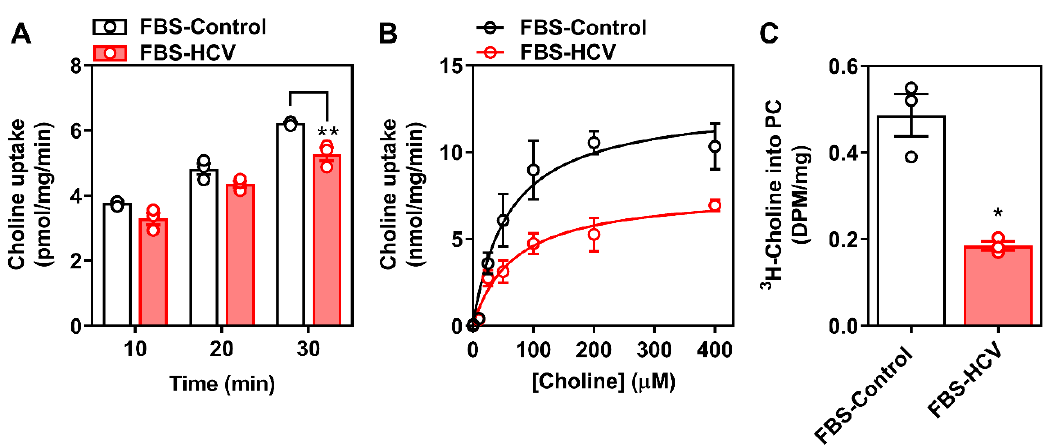
Figure 4. Choline uptake and incorporation into PC 24 h post-HCV infection. FBS-cultured Huh7.5 cells were infected at an MOI of 1 for 24 h. ( A ) [ 3 H]-choline uptake was determined over the course of 30 min; ( B ) [ 3 H]-choline uptake saturation kinetics were determined in the presence of increasing concentration of non-radiolabeled choline and fit to a Michaelis-Menten curve; and ( C ) [ 3 H]-choline incorporation into PC was then determined. Data are mean ± SEM, are representative of three independent experiments and normalized to total protein content, where * and ** represent statistical significance compared to uninfected control cells at p < 0.05 and p < 0.01, respectively.